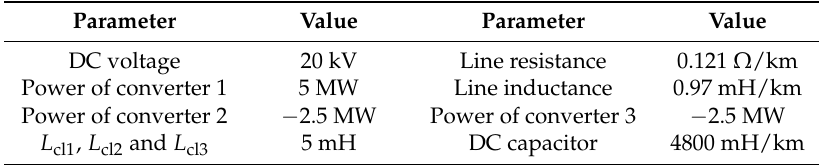
Table 1. Parameters of the simulation model.